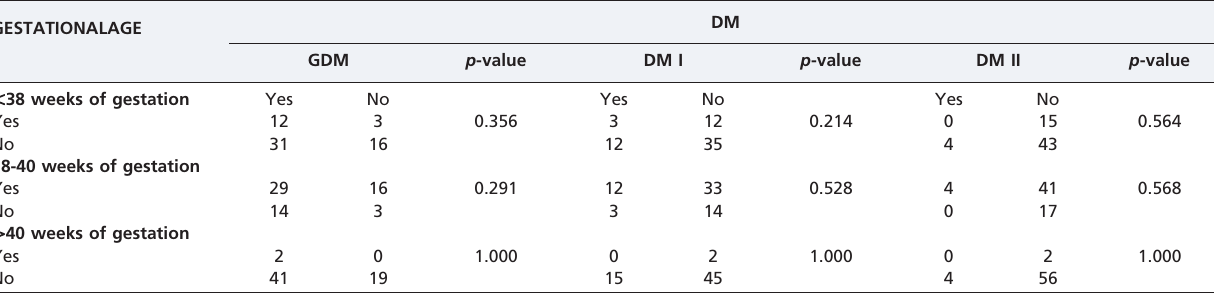
Table 5 - Gestational ages for 62 pregnant women with different types of diabetes mellitus from Goiaˆnia, Central-West Brazil, between August 2009 and July 2010.